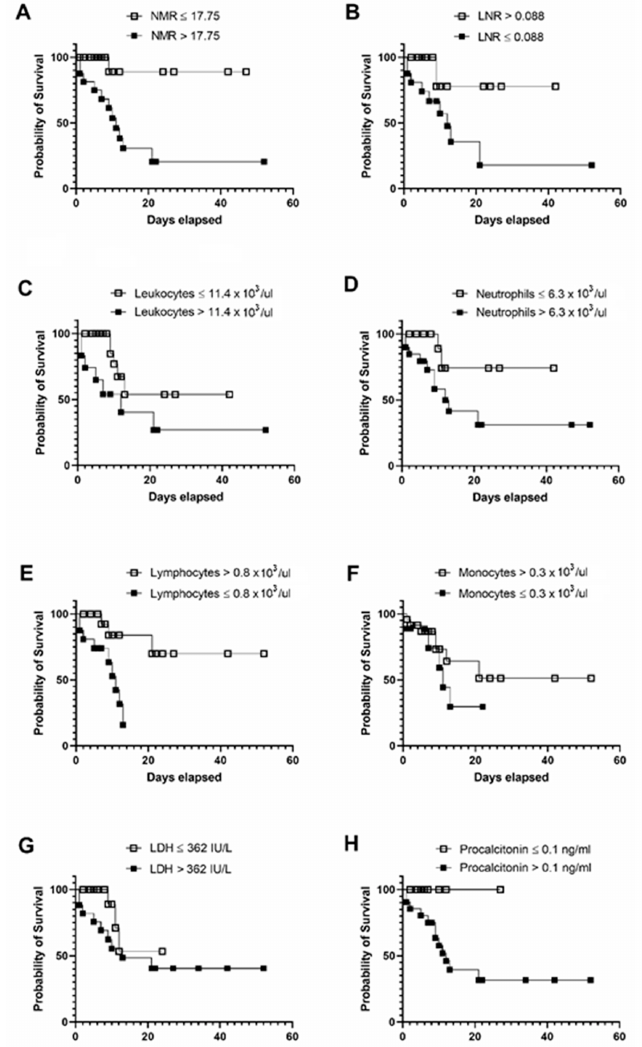
Figure 4. Kaplan–Meier curves for comparing the survival probability of di ff erent clinical predictors of in-hospital mortality at admission in patients seriously ill with Covid-19. ( A ) Patients with severe Covid-19 that show NMR > 17.75 at admission show 50% survival probability after 9 days of hospitalization. ( B ) Patients with LNR < 0.088 at admission show 50% survival probability after 12 days of hospitalization. ( C ) Patients with total leukocyte count > 11.4 × 10 3 / µ L at admission exhibit a significant decrease in the survival probability up to 20 days after hospitalization. ( D ) Patients with total neutrophil count > 6.3 × 10 3 / µ L at admission have 50% survival probability up to 13 days after hospitalization. ( E ) Patients with total lymphocyte count ≤ 0.8 × 10 3 / µ L at admission show a significant decrease in the survival probability up to 14 days after hospitalization. ( F ) Patients with total monocyte count ≤ 0.3 × 10 3 / µ L at admission exhibit a significant decrease in the survival probability up to 23 days after hospitalization. ( G ) Patients with LDH > 362 IU / L at admission show a significant decrease in the probability of survival up to 27 days after hospitalization. ( H ) Patients with procalcitonin values > 0.1 ng / mL at admission exhibit a 50% decrease in the survival probability after 12 days of hospitalization. Cut-o ff points for each marker are described at the top of the corresponding panel. Receiver operating characteristic (ROC) curves together with the Youden index was used to calculate optimal cut-o ff points for all markers. NMR resulted of dividing the total neutrophil count by the total monocyte count. LNR resulted of dividing the total lymphocyte count by the total neutrophil count. Survival analyses were performed by means of the Kaplan–Meier method using the GraphPad Prism 6.01 software. NMR, neutrophil-to-monocyte ratio; LNR, Lymphocyte-to-neutrophil ratio; LDH, lactate